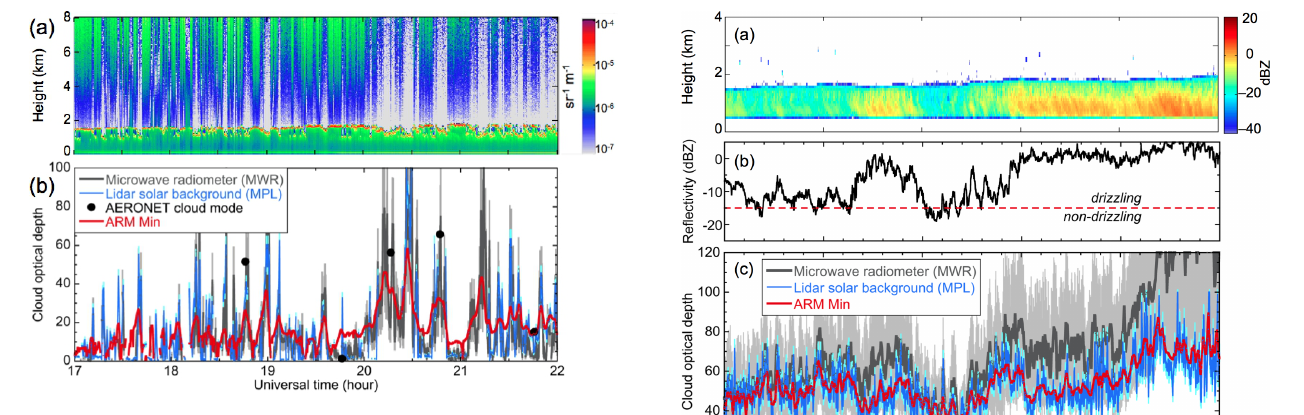
Figure 3. (a) Attenuated backscatter signals from micropulse lidar on 19 April 2005. (b) Time series of cloud optical depth retrieved from a microwave radiometer (MWR), lidar solar background sig- nals from micropulse lidar (MPL), AERONET cloud-mode obser- vations, and ARM Min product (using narrowband irradiance mea- surements). MWR-based retrievals (grey lines) are based on an as- sumed cloud effective radius of 8µm; grey error bars denote lower and upper limits for MWR values, corresponding to a change in droplet effective radius from 6 to 14µm.